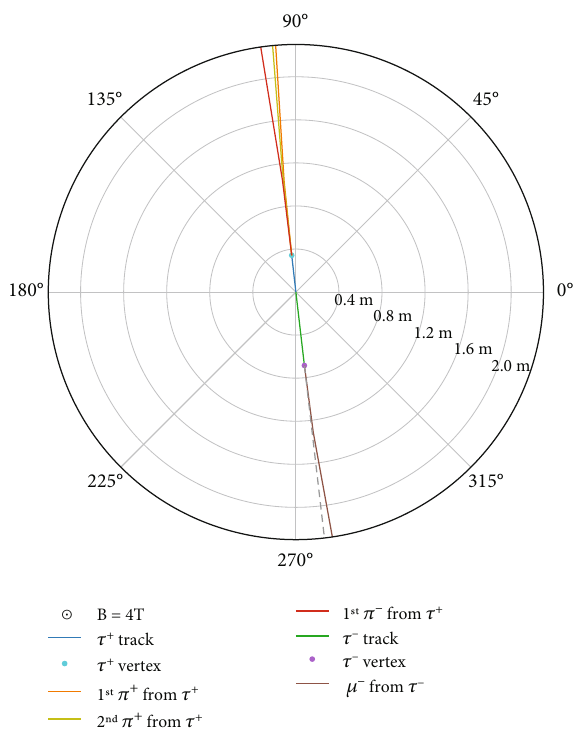
Figure 1: Sample tracks from long lived τ lepton produced at a muon collider with center of mass energy equals 3TeV. τ + undergoes 3-prong decay while τ − decays to μ − plus two neutrinos. For illustration purposes, τ + ð τ − Þ lifetime is set to 5 (10) times the mean life time. The blue and green solid lines indicate the tau tracks which can be matched with the displaced vertex (the cross point of the three charged pions) and the decayed muon track (in purple), respectively. The green dashed line indicates the original direction of muon